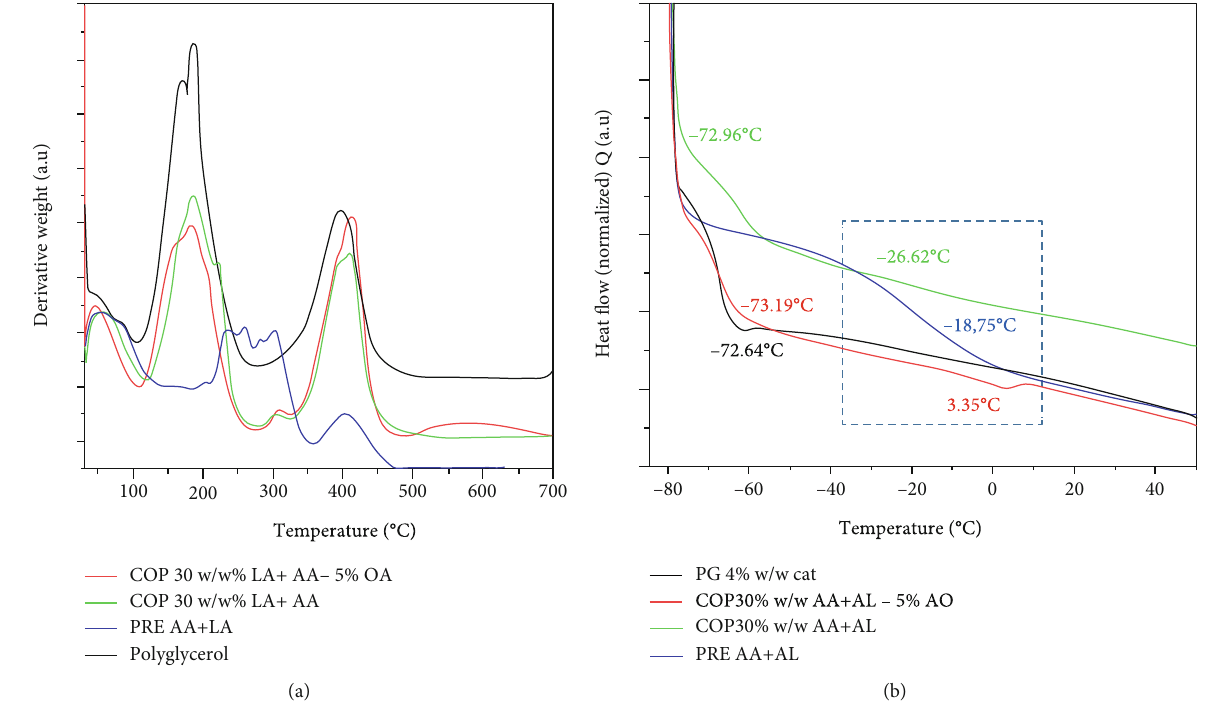
Figure 2: (a) Derivative weight and (b) DCS thermograms of synthesized materials.